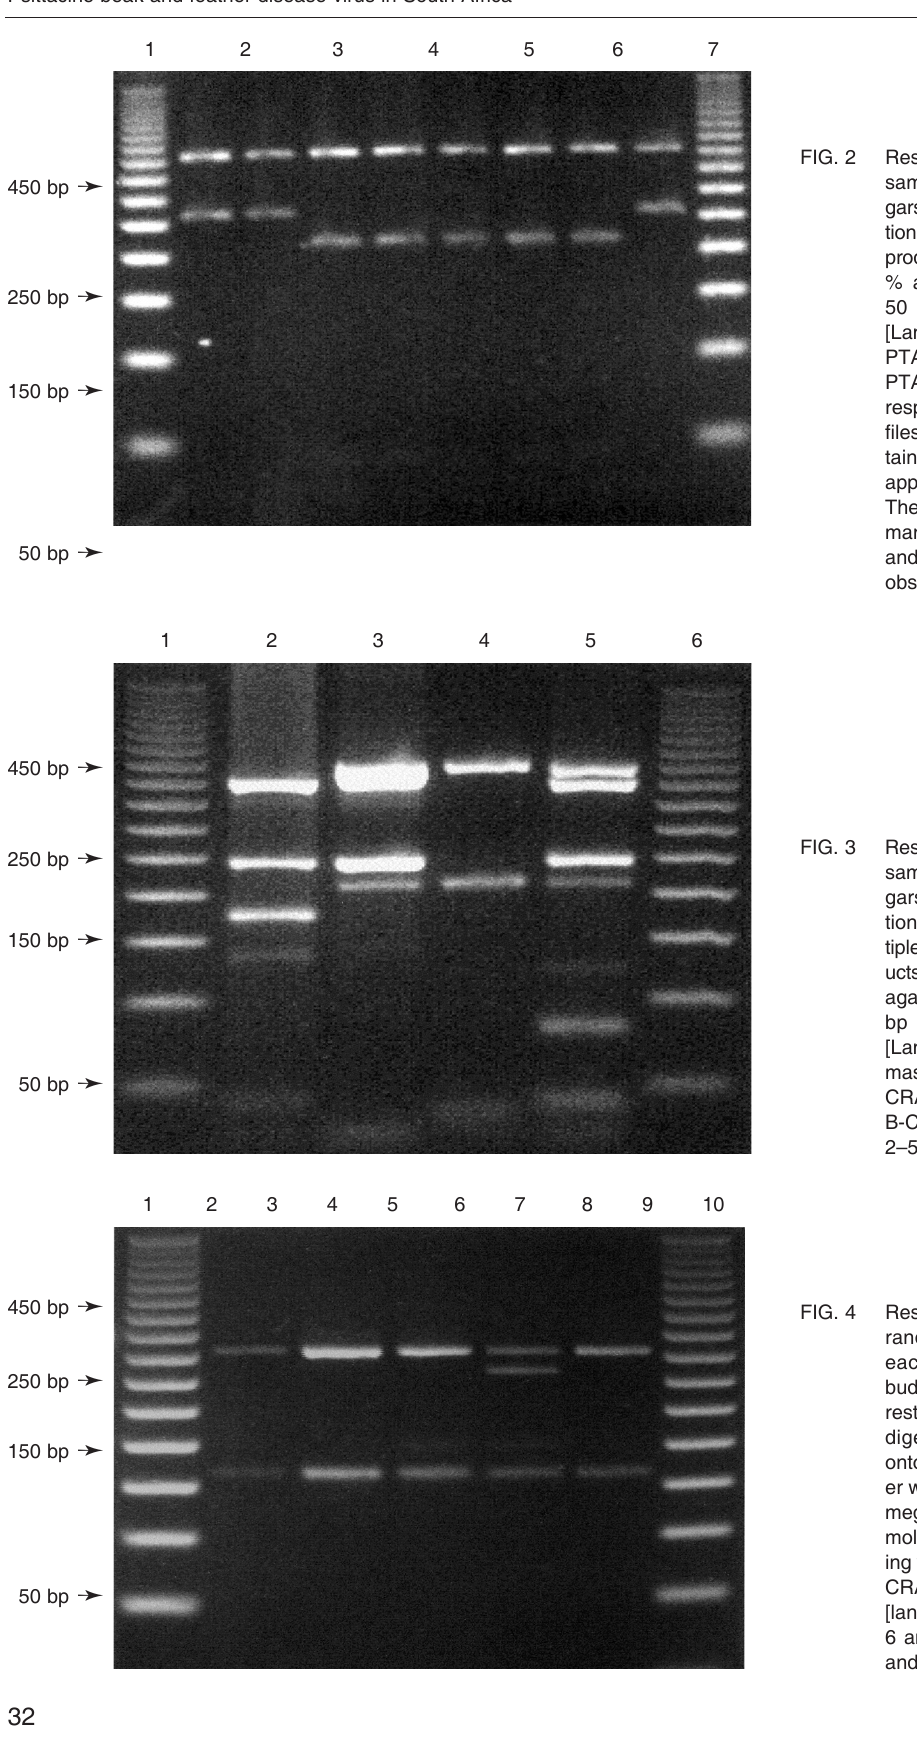
FIG. 2 Restriction digest profile for the samples obtained from budgeri- gars (Pretoria) using the restric- tion enzyme Hae III. The digest products were loaded onto a 2.5 % agarose gel together with a 50 bp step ladder (Promega) [Lanes 1 and 7]. The samples B- PTA-1, B-PTA-2, B-PTA-3, B- PTA-4 and B-PTA-5 (lanes 2–6 respectively) gave similar pro- files with sample B-PTA-4 con- taining an additional fragment of approximately 370 bp in size. The fragments below the 50 bp marker were light in intensity and therefore more difficult to observe